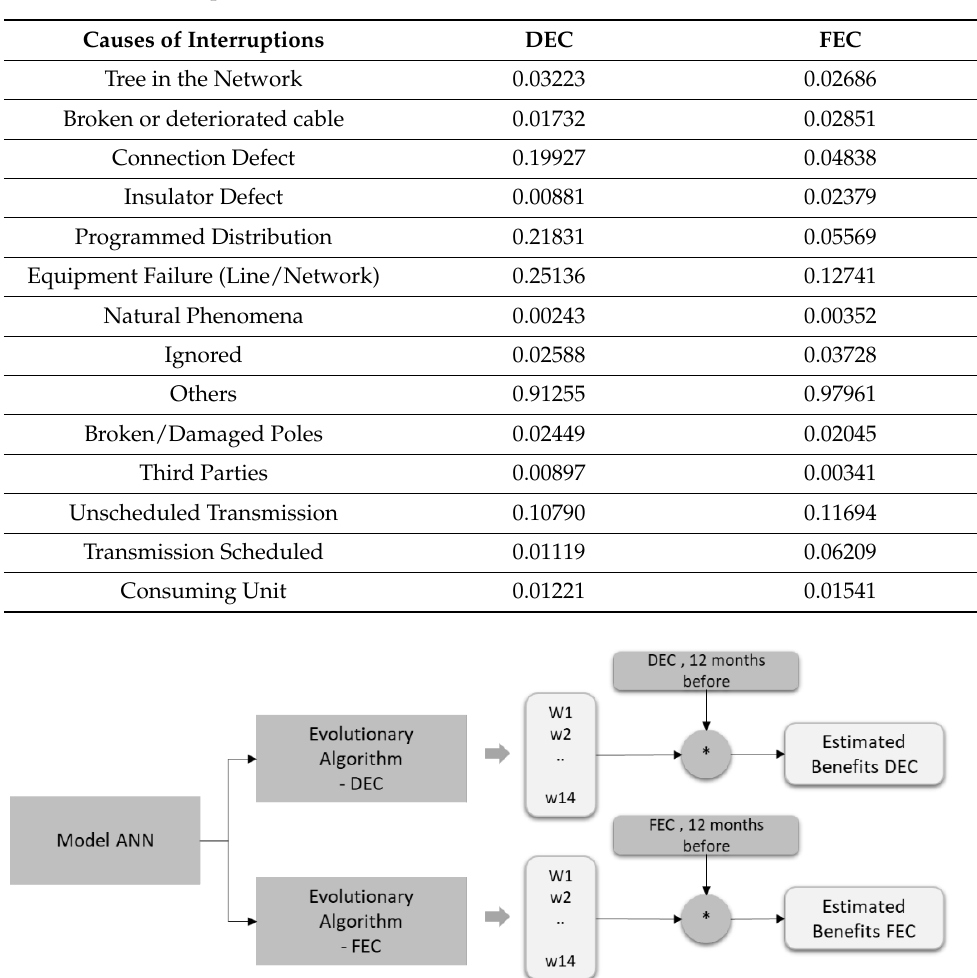
Table 4. The heat map of DEC and FEC.